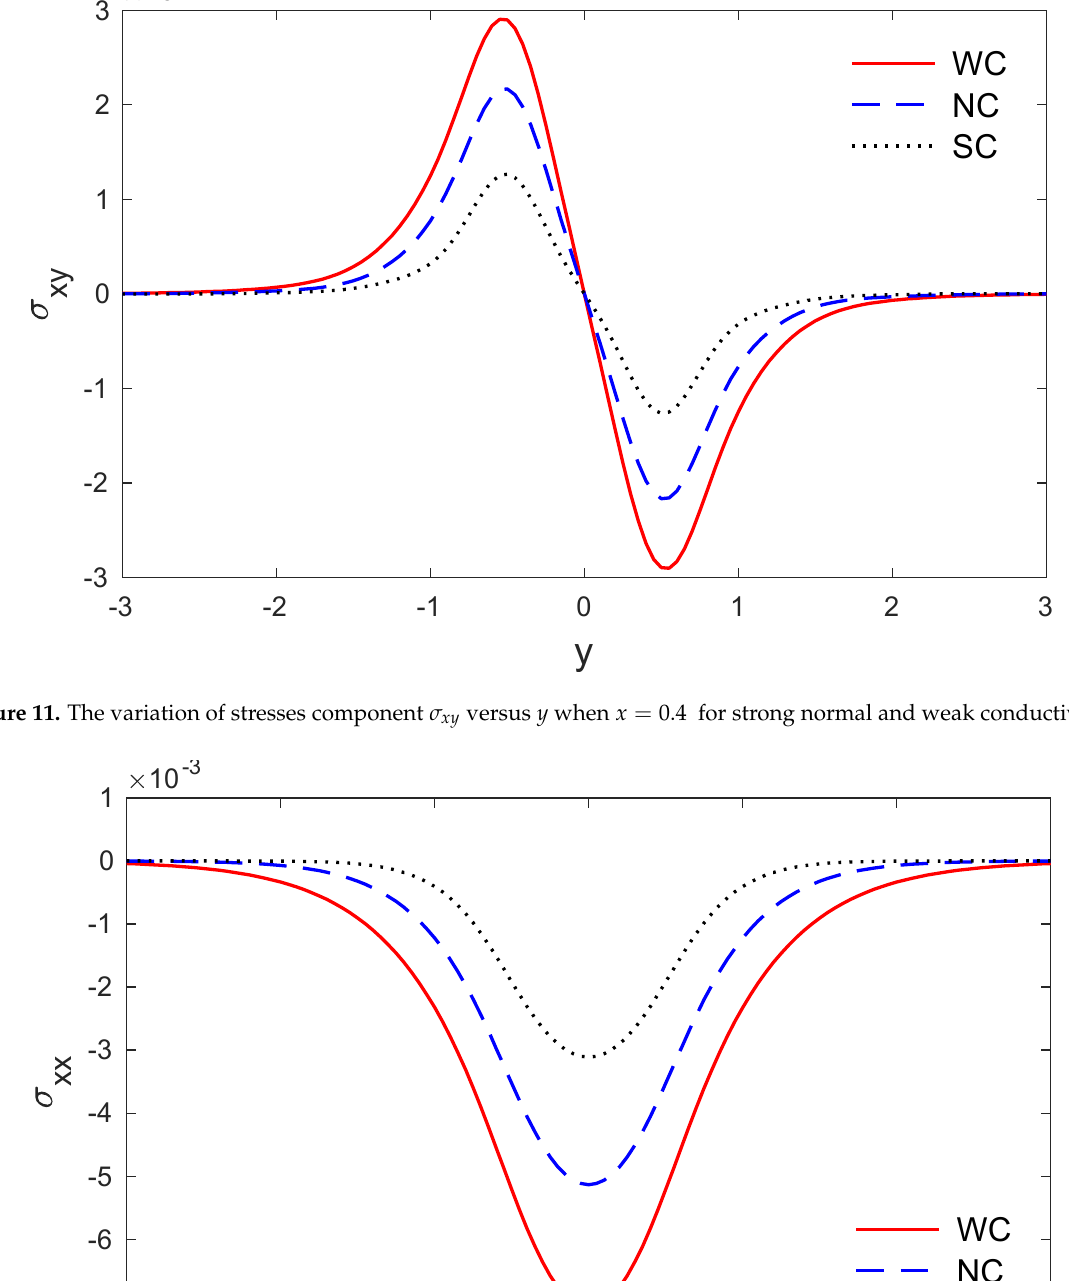
Figure 10. The variations of horizontal displacement (cid:1873) via (cid:1877) with (cid:1876) = 0.4 for strong normal and weak conductivities.